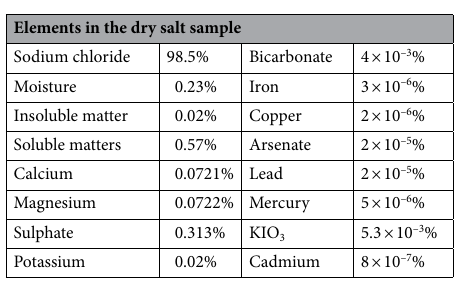
Table 1. Chemical properties of the used salt.